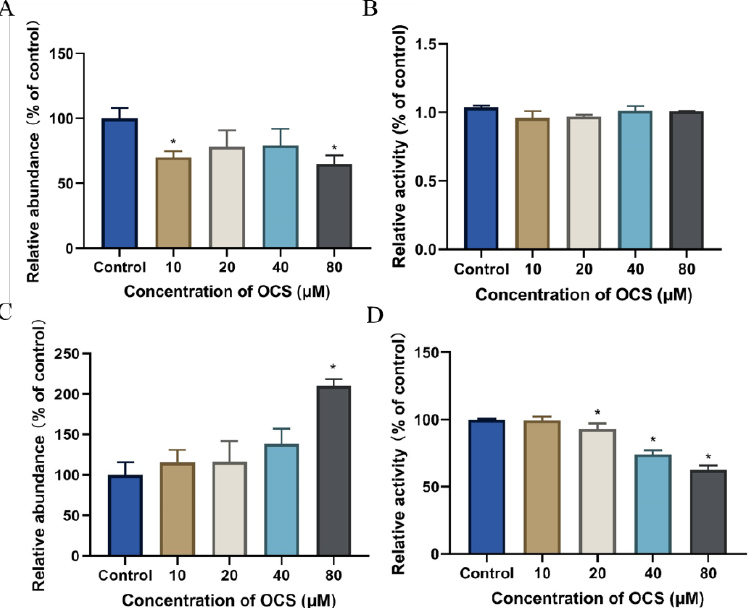
Figure 3. OCS-induced oxidative stress in HepG2 cells after exposed for 24 h. ( A ) Glutathione depletion; ( B ) Superoxide dismutase; ( C ) Lipid peroxidation based on MDA; ( D ) Catalase activity; Values are mean ± SD of three independent experiments ( n = 3). (* p < 0.05 vs. control).